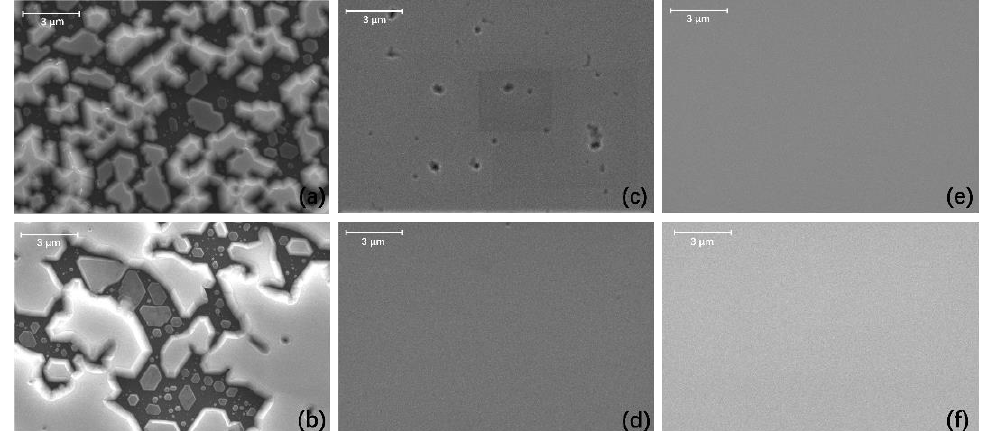
Figure 3. Top-view SEM images of GaN films on ( a ) 10 nm, ( c ) 25 nm, and ( e ) 40 nm sputtered AlON / CSS templates at stage 1; GaN films on ( b ) 10 nm, ( d ) 25 nm, and ( f ) 40 nm sputtered AlON / CSS templates at stage 2.